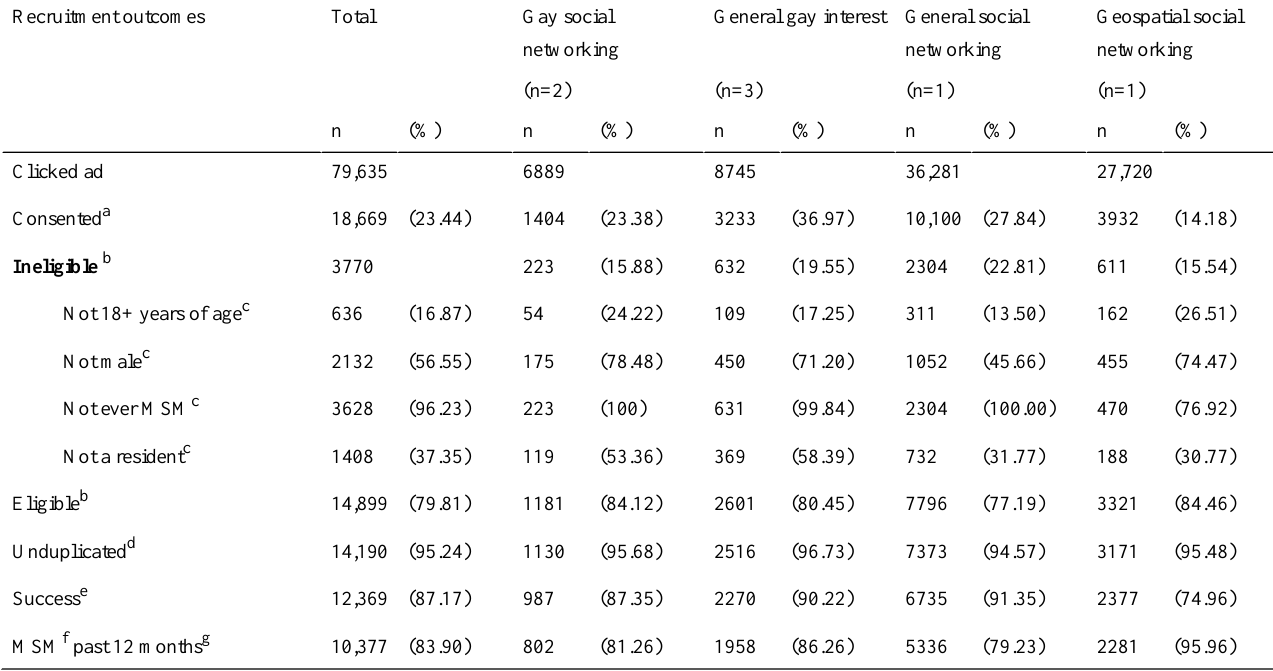
Table 1. Recruitment outcomes with different recruitment website types for the American Men’s Internet Survey, United States, 2013.